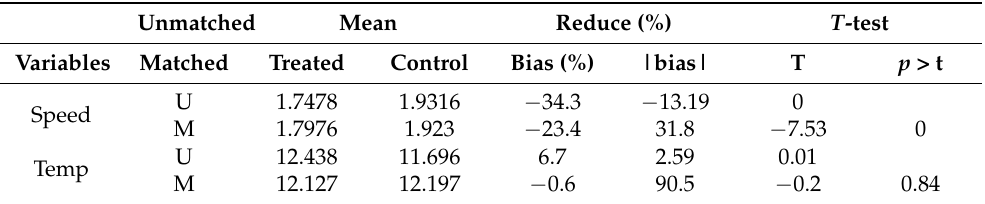
Table 6. PSM model result.